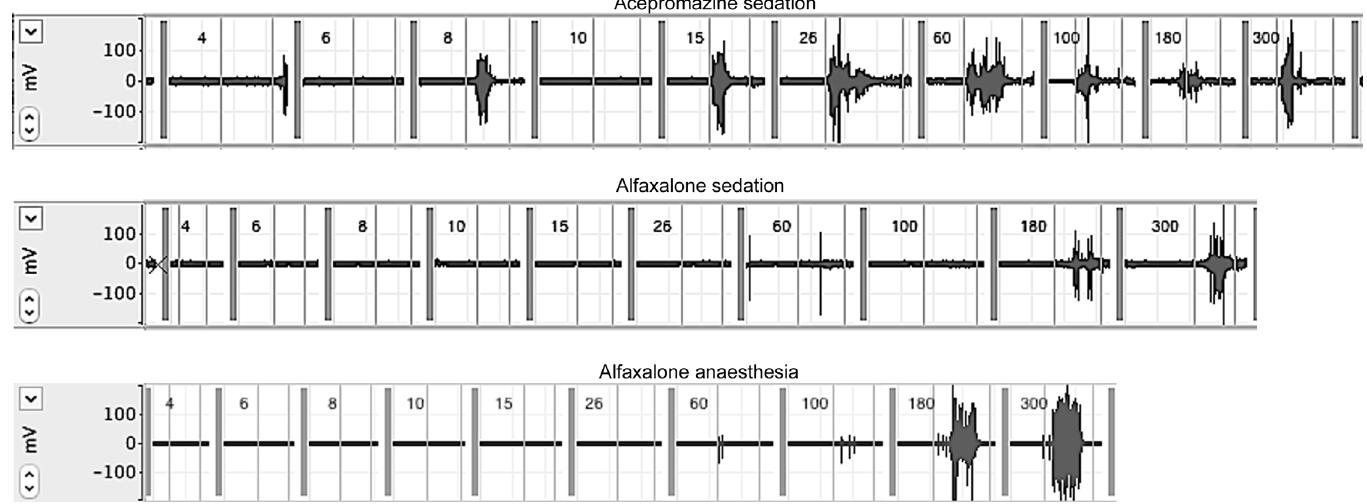
Fig 4. EMG recordings from cranial tibial muscle of dog 3 in response to application of increasing weights of von Frey filaments. Upper trace following acepromazine sedation, middle trace following alfaxalone sedation and lower trace following alfaxalone anaesthesia. Weights of von Frey filaments are shown on each trace in grams, thin grey vertical lines represent the period during which stimulation was applied at each